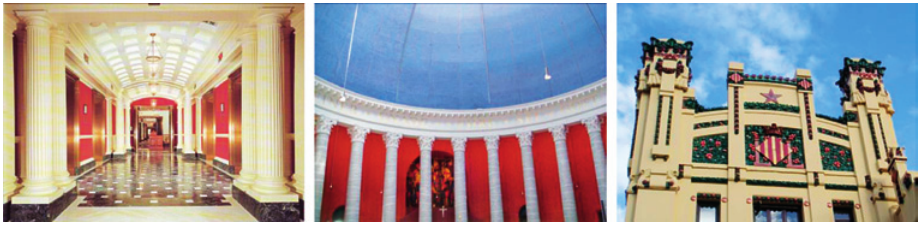
Fig. 29. Allan Greenberg. Fig. 30. Georg Moller. Fig. 31. Demetrio Ribes